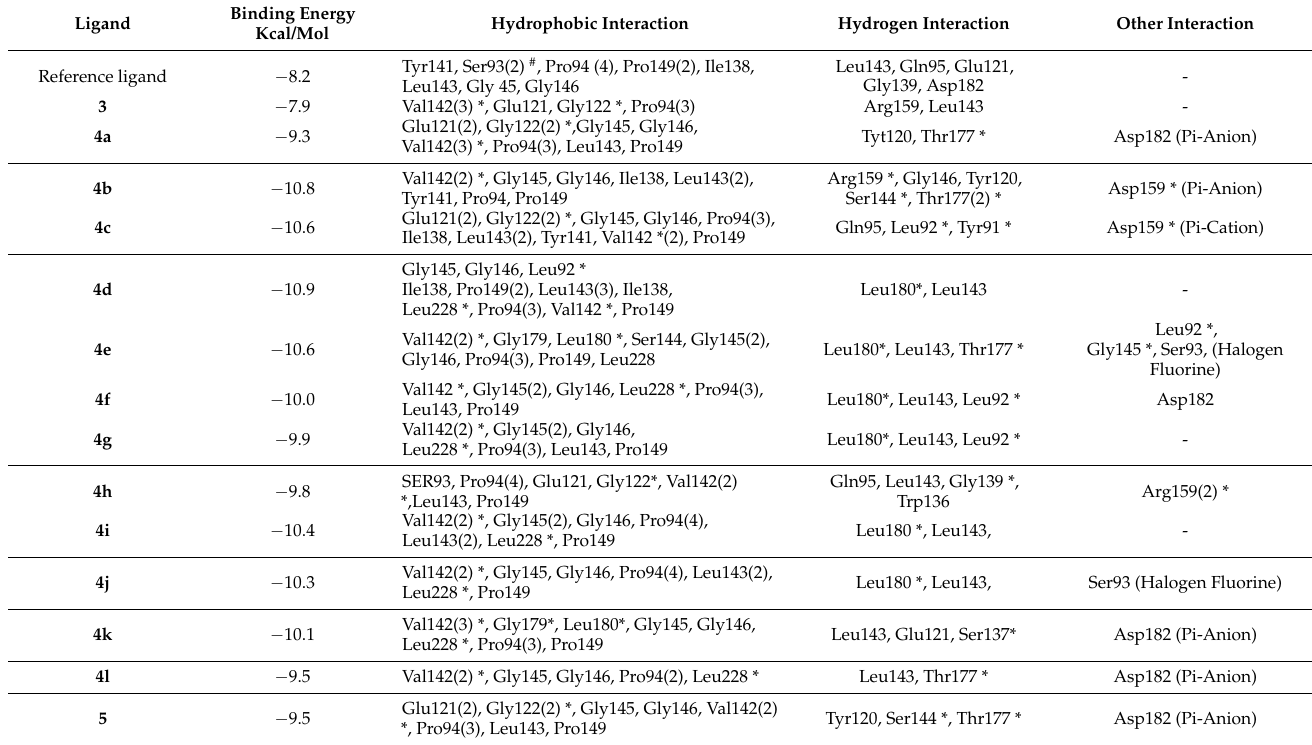
Table 1. The results of the target thieno[2,3- d ]pyrimidines 3, 4a-l, 5 and the reference ligand docking studies to the active site of P. aeruginosa